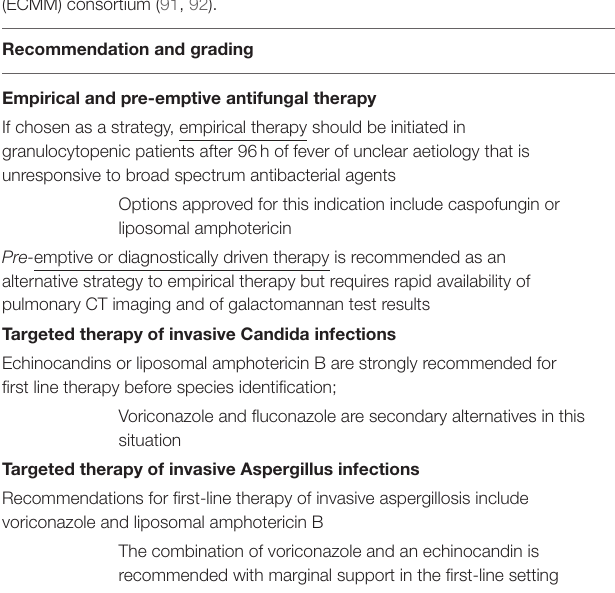
TABLE 3 | Summary of ECIL-8 recommendations for empirical, pre-emptive, and targeted therapy of IFDs (modified from Groll et al. ECIL-8 recommendations; for management of mucormycosis, rare moulds and rare yeast, please see the updated recommendations of the European Confederation of Medical Mycology (ECMM) consortium (91,